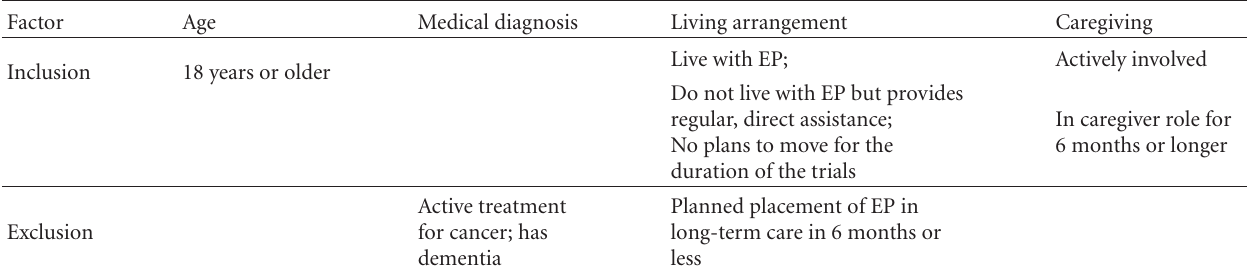
Table 2: Inclusion and exclusion criteria for